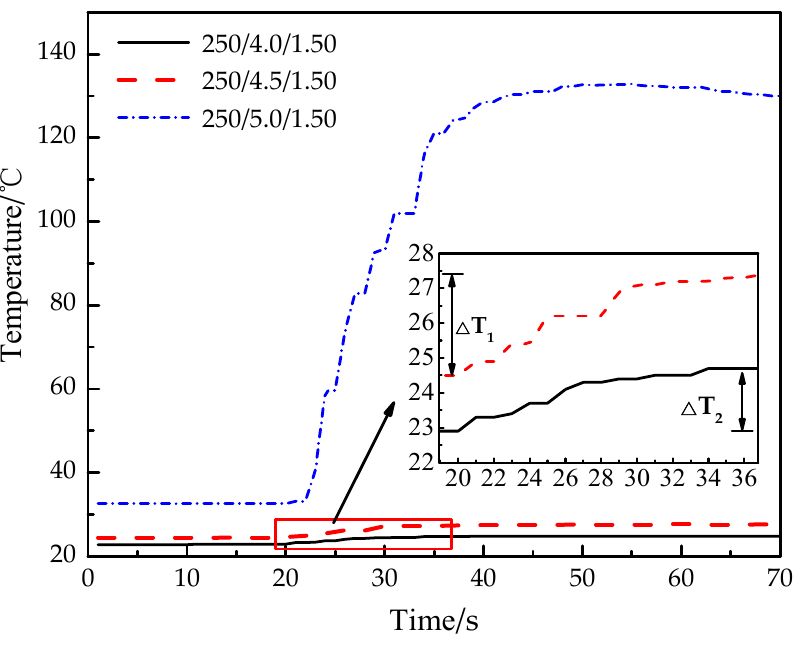
Figure 8. Real-time temperature curve of experiments 3, 6 and 9.